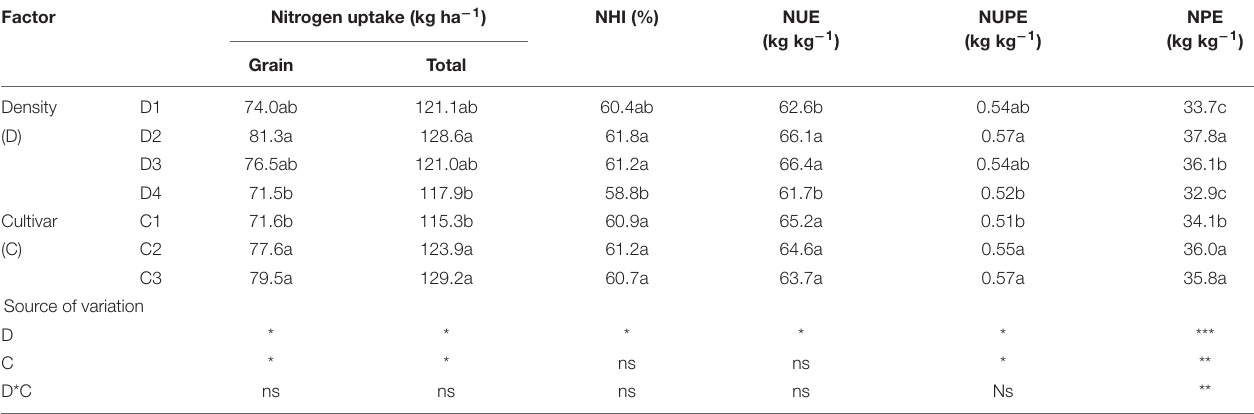
TABLE 4 | Nitrogen uptake and utilization by dryland maize in different treatments. Factor